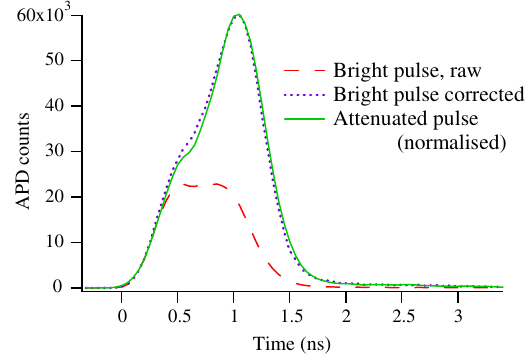
FIG. 4. Skew due to dead time can be compensated with an appropriate correction algorithm. The raw measurement is both reduced in magnitude and shifted towards the leading edge, due to the dead time effect. The correct pulse shape is restored after correction as can be seen by comparison with an attenuated pulse for which the dead time effect is negligible. The integral of the attenuated pulse has been normalized to that of the corrected bright